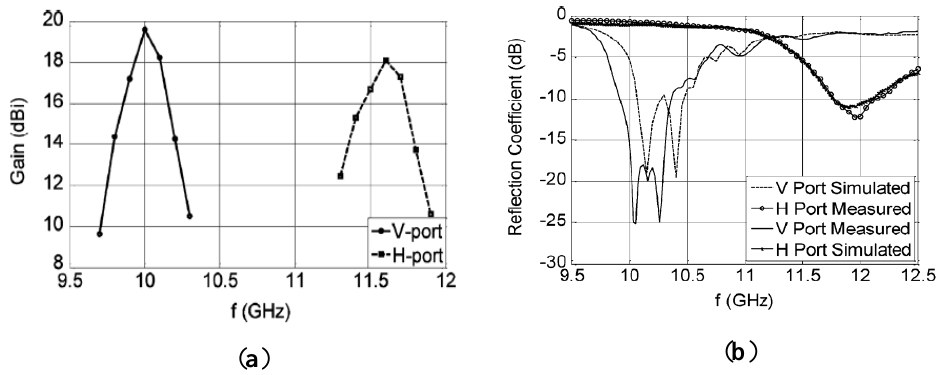
Figure 20. Results of the RCA in [159]: ( a ) Gain; ( b ) Reflection